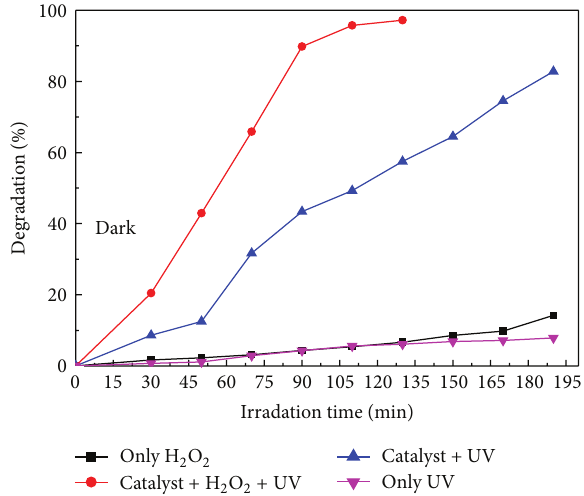
Figure 7: Phenol photodegradation route with different process